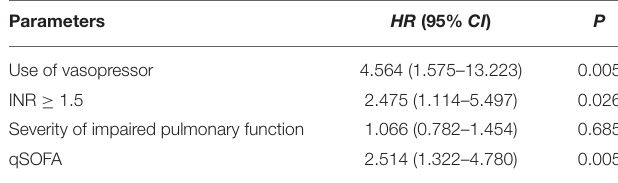
TABLE 4 | Multivariate Cox analysis of factor related to hospital mortality based on LASSO regression in patients with sepsis received